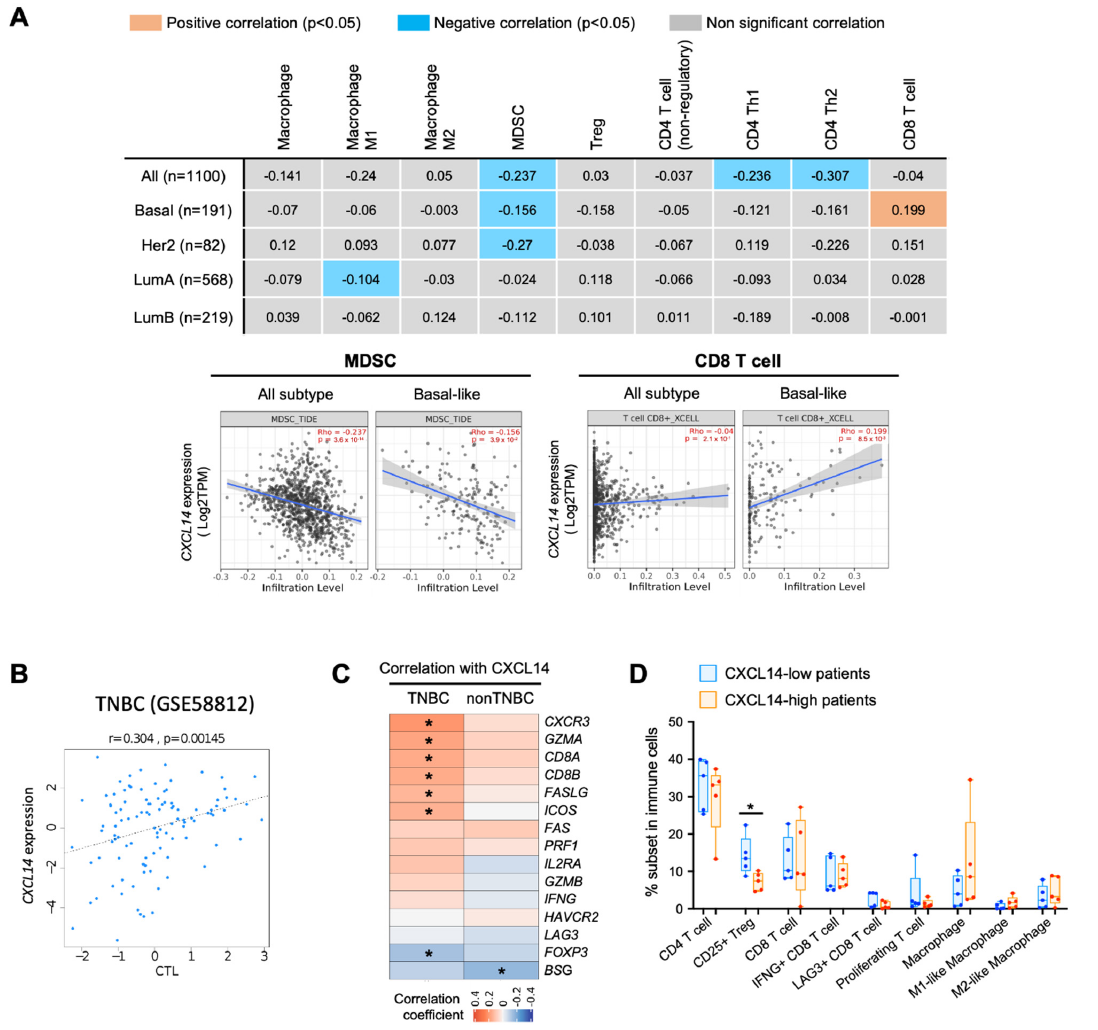
Figure 6. Correlation of CXCL14 expression with immune profile. ( A ) Correlation coefficient between CXCL14 expression and immune cell subset in TCGA breast-cancer dataset (upper panel) and scatter plots of CXCL14 expression and immune infiltration p < 0.05 in Basal-like breast cancer (lower panel). ( B ) Correlation of CXCL14 expression with cytotoxic T lymphocyte level (CTL score) by TIDE (Tumor Immune Dysfunction and Exclusion) analysis in TNBC dataset (GSE58821). ( C ) Correlation coefficient between CXCL14 and T cell functional markers in METABRIC dataset. ( D ) Comparison of immune cell profile between patients with low- and high- CXCL14 in single cell RNA-seq data (GSE107764). Data are presented as mean ± SD. * p < 0.05.